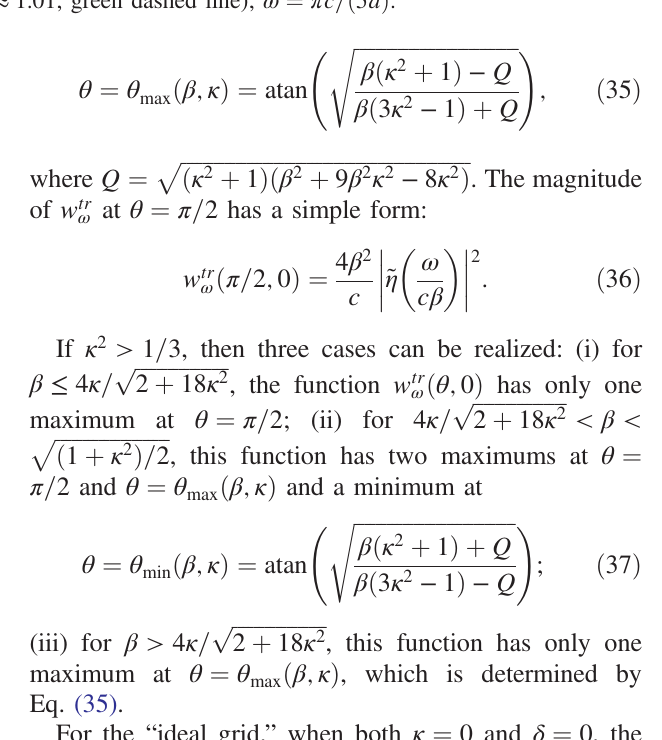
FIG. 8. Total angular spectral density of volume radiation w tr ω depending on θ for the case of perfectly conductive wires ( δ ¼ 0 ). The energy density is measured in 4 j ~ η j 2 =c units; the azimuthal angle is φ ¼ 0 ; a ¼ 10 mm; r 0 ¼ 1 mm ( κ ≈ 0 . 09 , red solid line), r 0 . 1 mm ( κ ≈ 0 . 55 , blue dotted line), and r 0 . 01 mm ( κ ≈ 1 . 01 , green dashed line); ω ¼ π c= ð 5 a Þ 0 ¼ 0 ¼